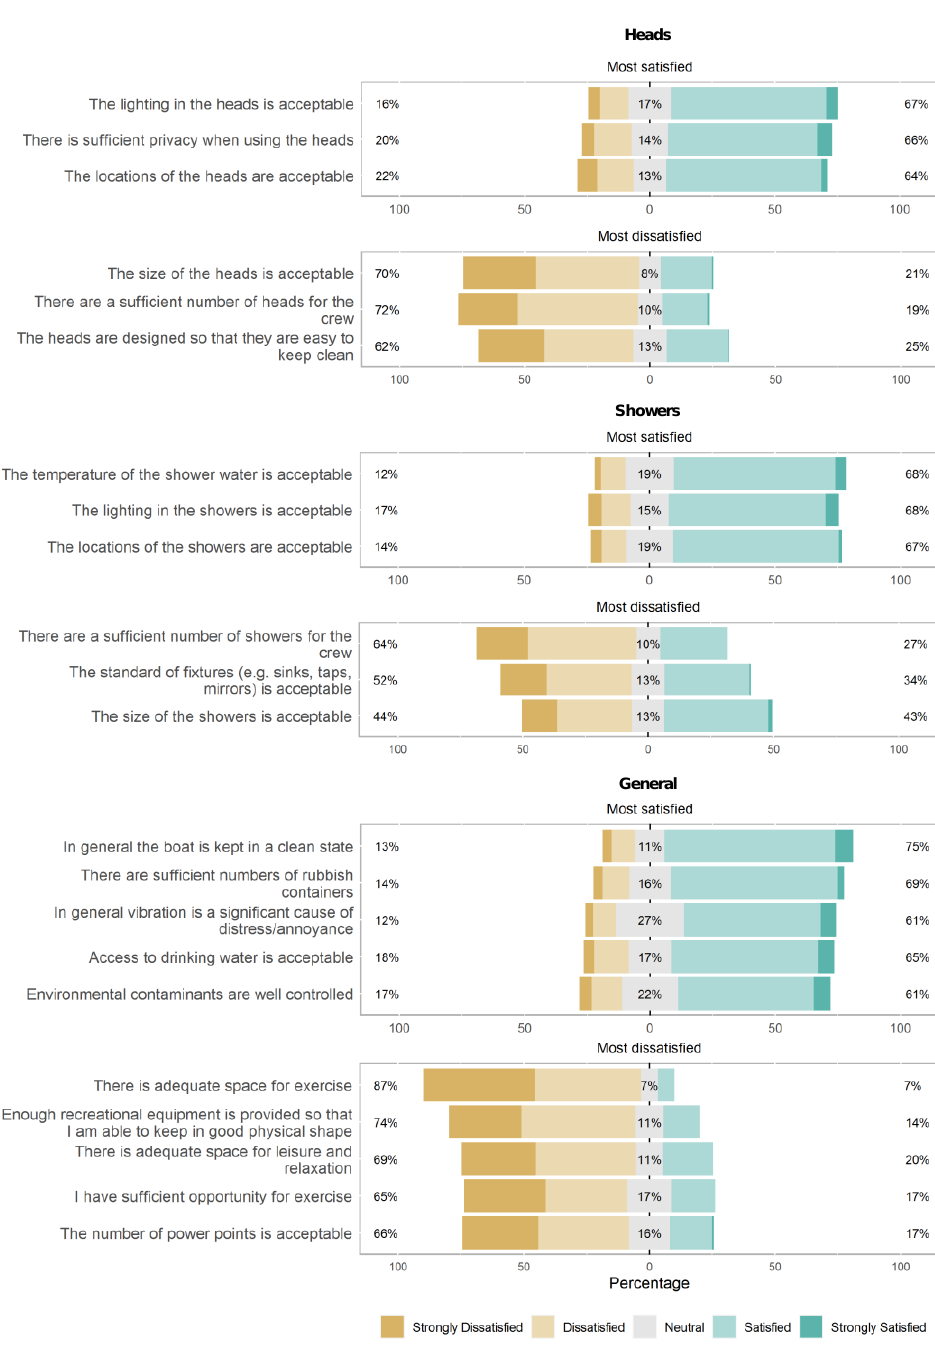
Figure 3. Items with the highest satisfaction and dissatisfaction ratings for each submarine area. Values reflect (left to right) the percent of combined strongly dissatisfied and dissatisfied responses, percent of neutral responses, and percent of combined satisfied and strongly satisfied responses.